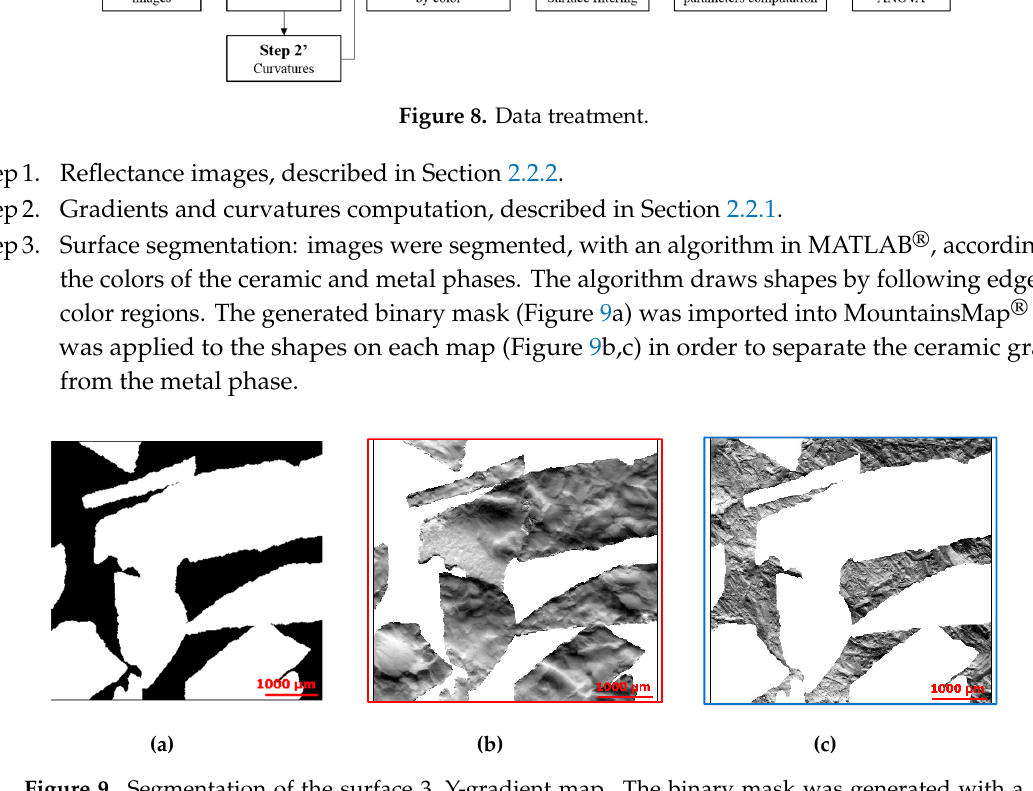
Figure 9. Segmentation of the surface 3, Y-gradient map. The binary mask was generated with a MATLAB ® algorithm ( a ), and ceramic ( b ) and metal ( c ) phases were obtained after application of the mask (MountainsMap ® ).